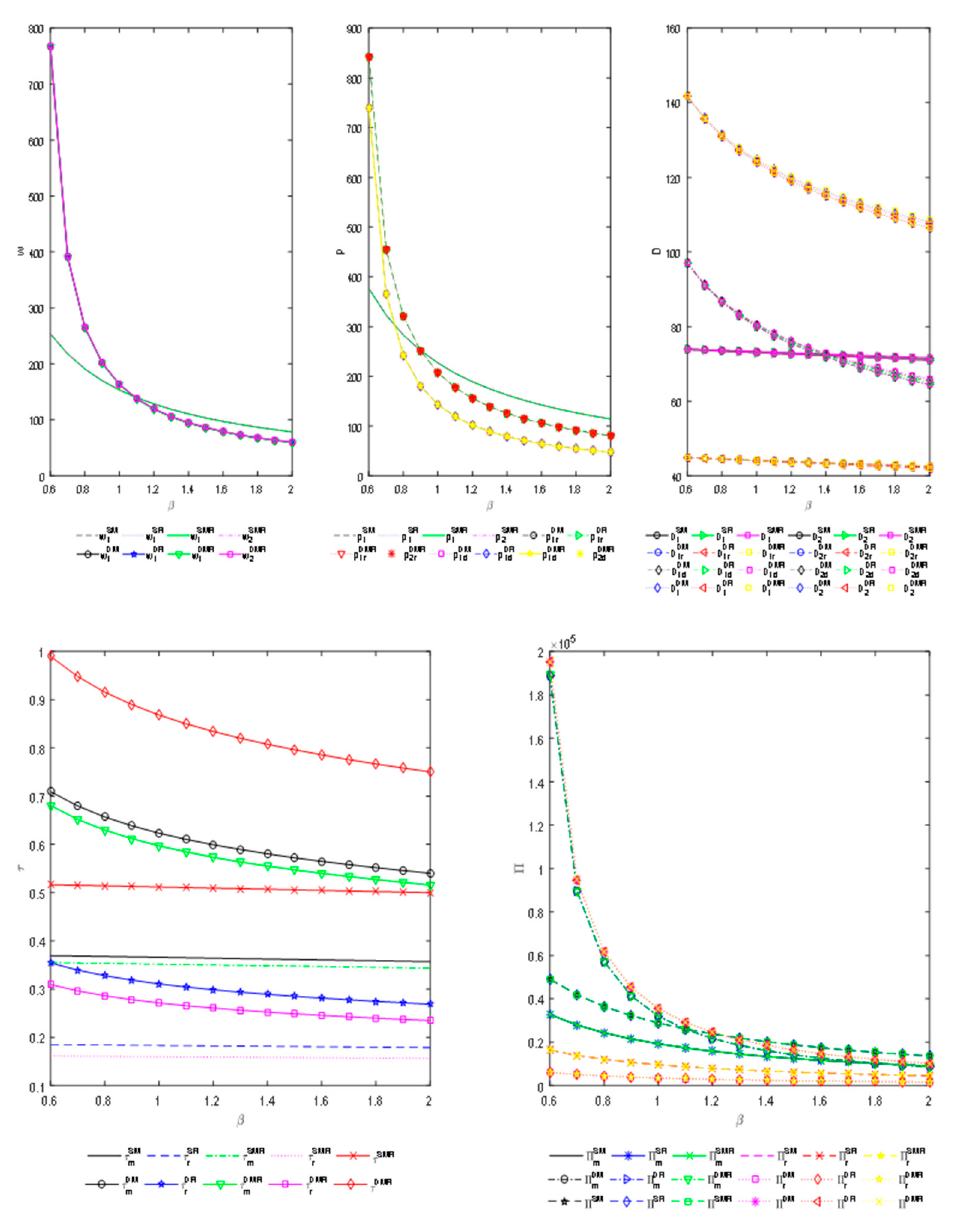
Figure 5. Changes of the wholesale price/selling price/market demand/collecting rate/profit with β